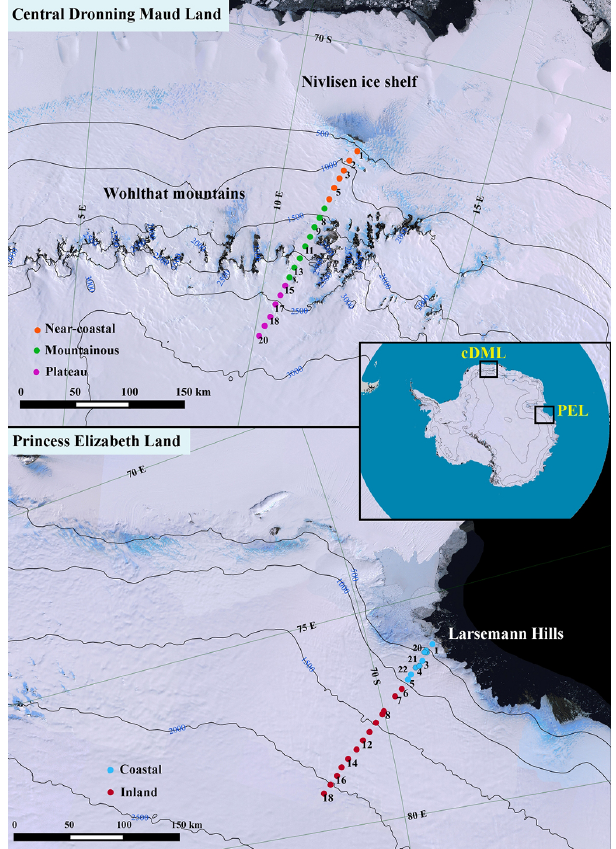
Figure 1. Study region showing sampling locations along transects in central Dronning Maud Land (top panel) and Princess Elizabeth Land (bottom panel), East Antarctica. Colour-coded sampling loca- tions indicate different topographic sections. Inset shows the study area highlighted in Antarctica. Maps were created using LANDSAT Mosaic using QGIS Wien (v.2.8) in conjunction with Quantarctica